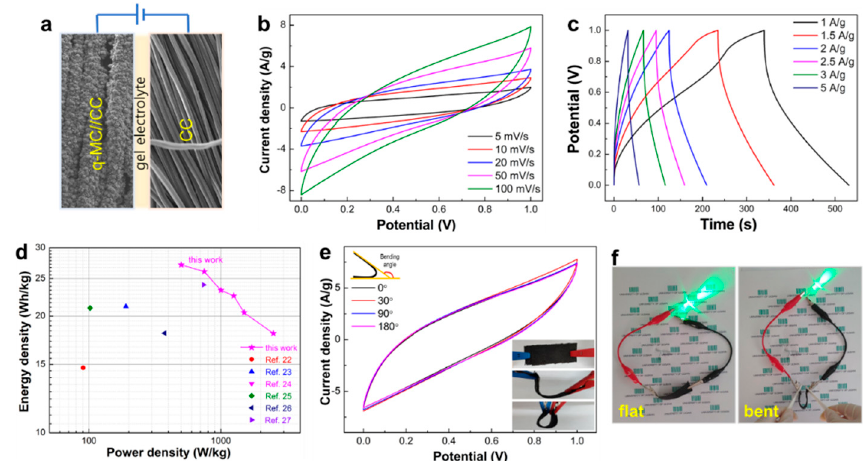
Figure 6. ( a ) Schematic illustration of assembly of all-solid-state asymmetric flexible supercapacitor (ASC). ( b ) Cyclic voltammetry (CV) curves at different scan rates and ( c ) galvanostatic charge–discharge curves at different current densities of ASC devices. ( d ) The Ragone plots of ASC devices and reported Mn-based supercapacitors. ( e ) CV curves of the ASC under mechanical bending. ( f ) Photo image of lighting LED (light-emitting diode) powered by ASC devices under flat and bent state.